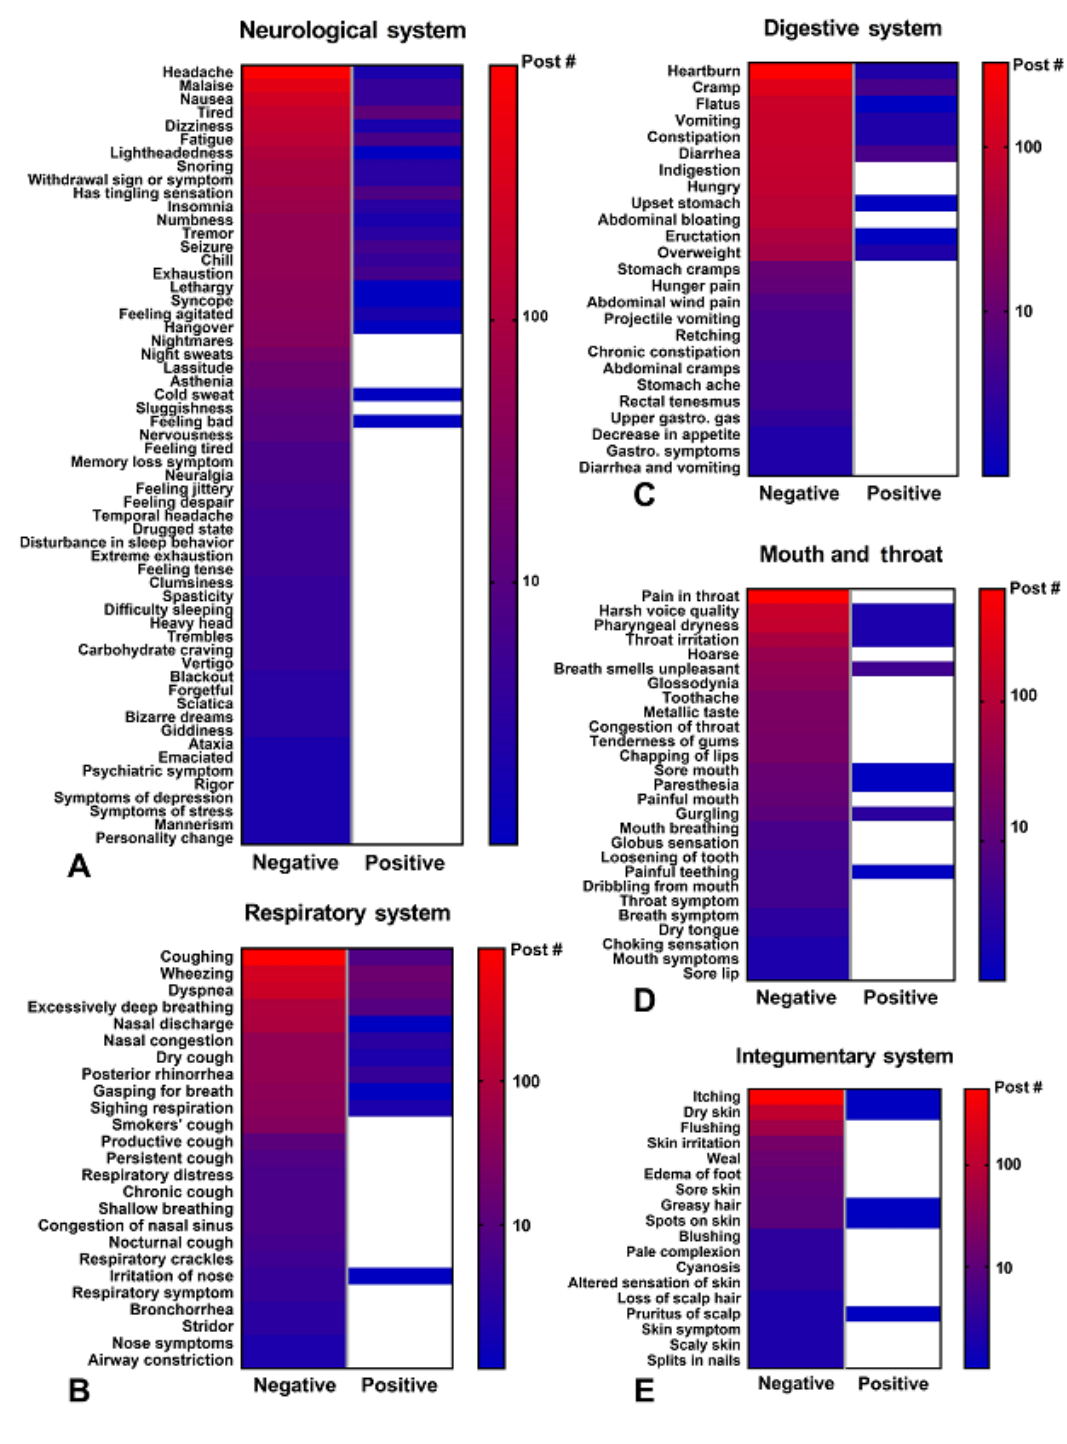
Figure 4. Heat map of specific symptoms reported in the neurological, respiratory, digestive, mouth and throat, and integumentary systems. The total number of posts for each symptom is shown on a log scale ranging from high (red) to low